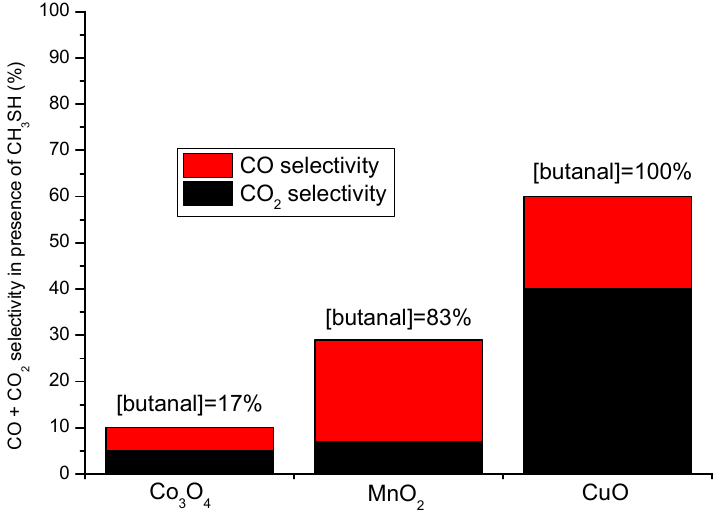
Figure 4. Catalysts’ comparison in presence of CH 3 SH at 400 °C after 150 h ([butanal conversion]) from [86].